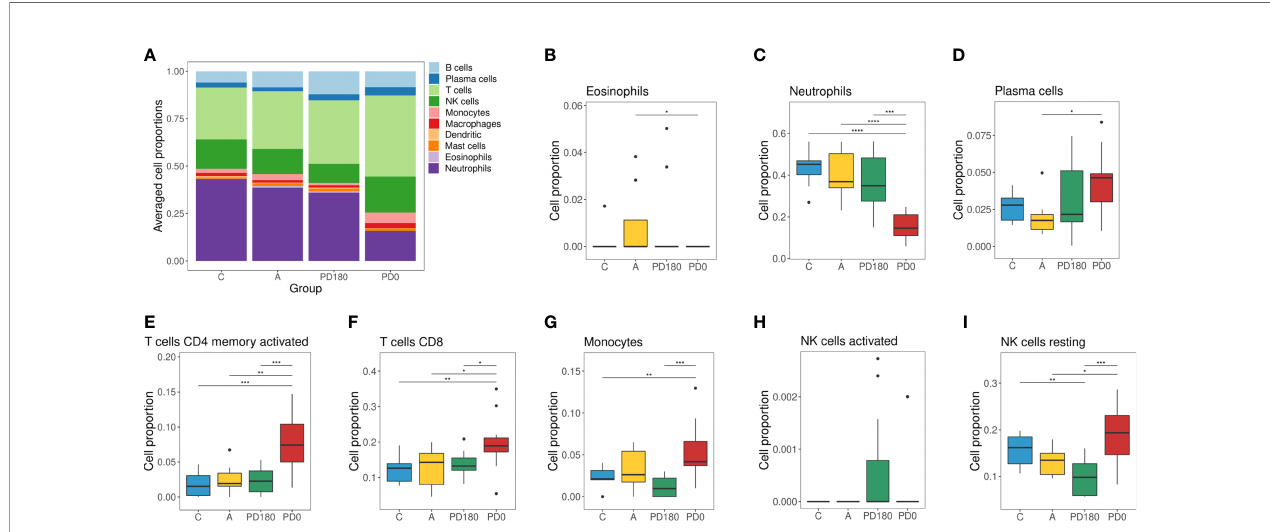
FIGURE 4 | Cellular deconvolution of blood transcriptomes in human visceral leishmaniasis using the CIBERSORT method: (A) Leukocyte proportions inferred from gene expression pro fi les of blood samples. Plots by cell type displaying the relative cell proportions for eosinophils (B) , neutrophils (C) , plasma cells (D) , activated memory CD4 cells (E) , CD8 T cells (F) , monocytes (G) , activated NK (H) cells and resting NK cells (I) . Groups were classi fi ed as active VL (PD0) and VL-free (PD180, A and C groups), in which the PD180 subjects were treated and considered clinically cured after 180 days of disease follow-up (PD0 and PD180 are paired groups, n = 11); A: asymptomatic (n = 9); C: healthy uninfected controls (n = 9). The differences between cell proportions were evaluated by Wilcoxon with Holm ’ s correction. *P < 0.05, **P < 0.01, and ***P <